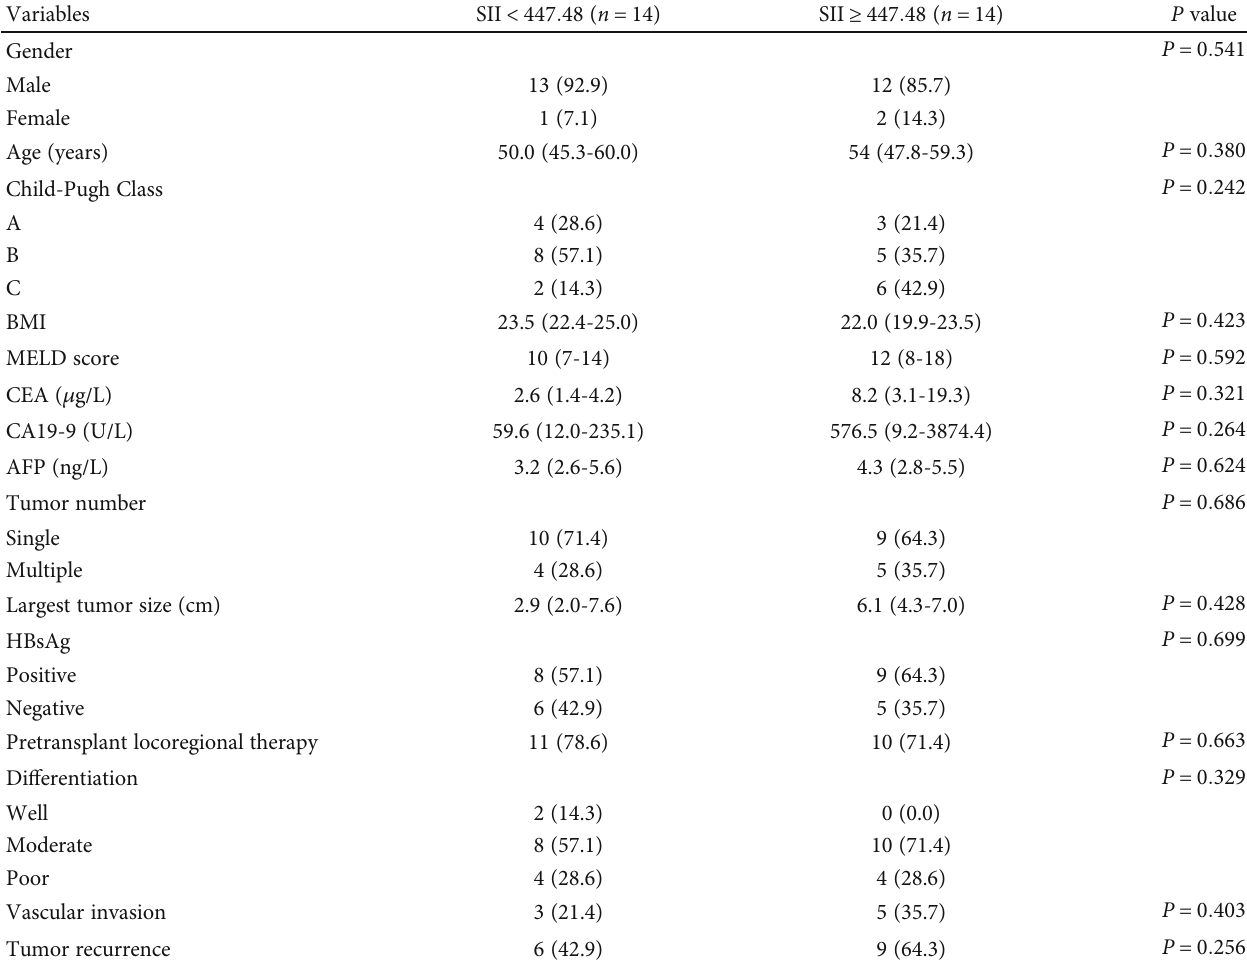
Table 2: Comparison of characteristics between the high SII group and low SII group of patients with iCCA who underwent LT. Variables